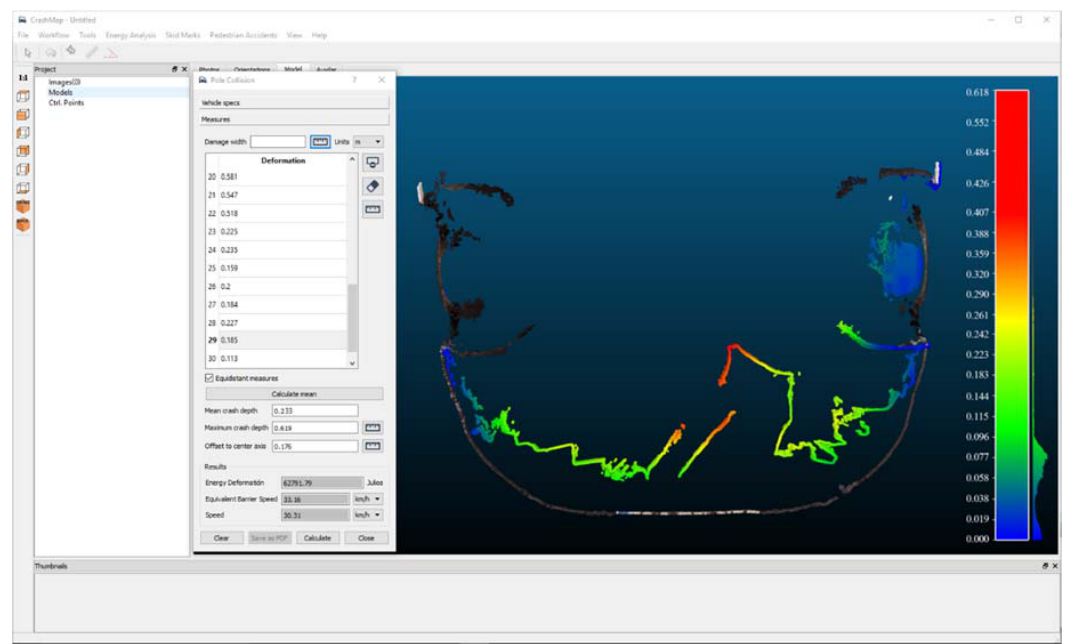
Figure 10. Interface of the CRASHMAP_desktop during the energetic evaluation.